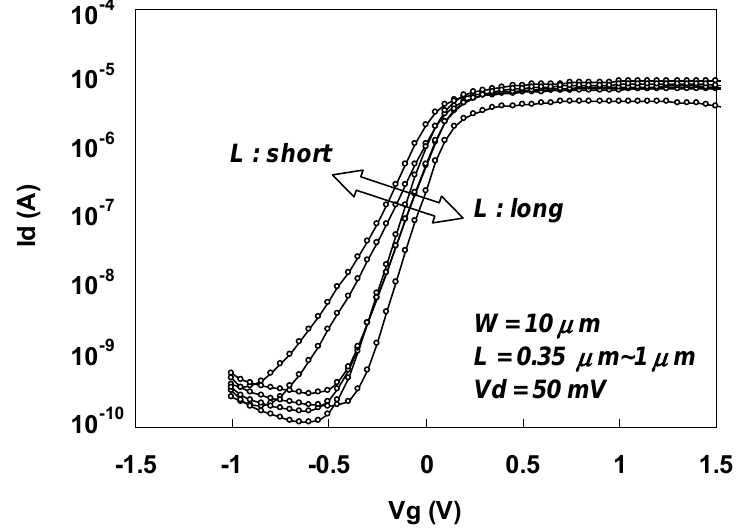
Figure 45. Id-Vd characteristics for an n-MOSFET annealed 1 min at 450 °C after sulfur